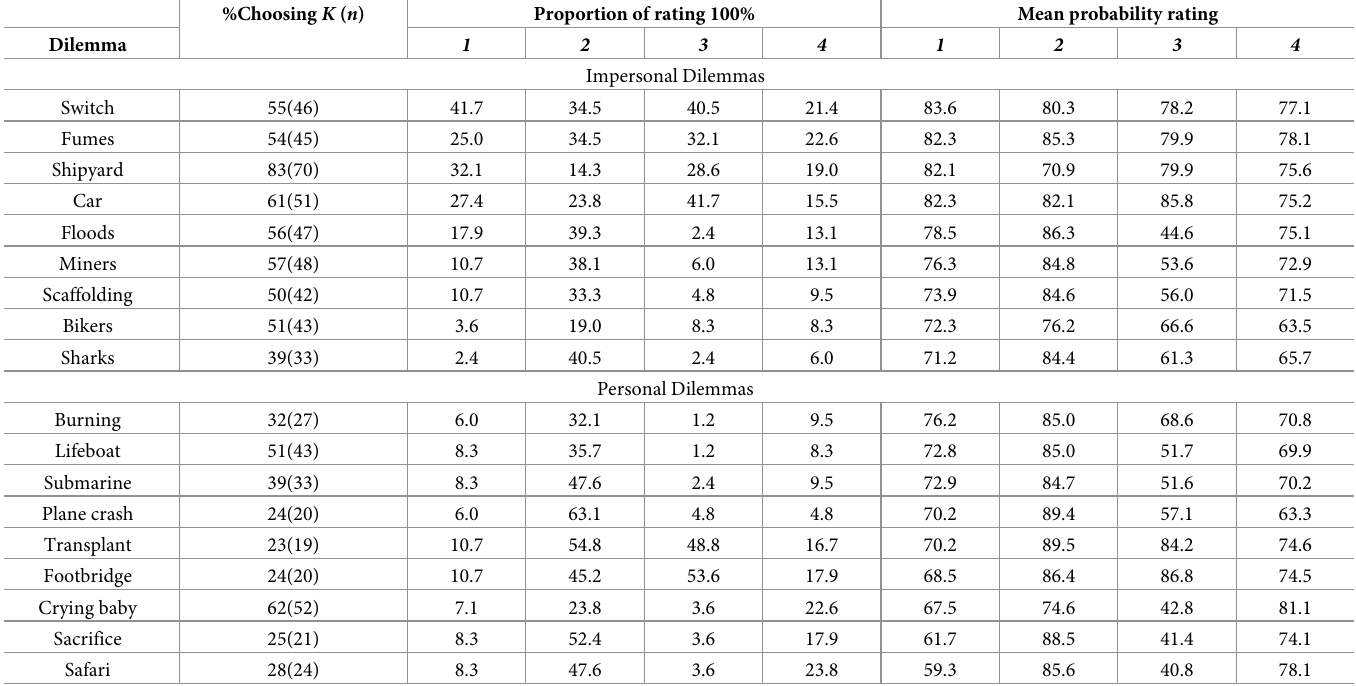
Table 1. Descriptive statistics for individual moral dilemmas in study